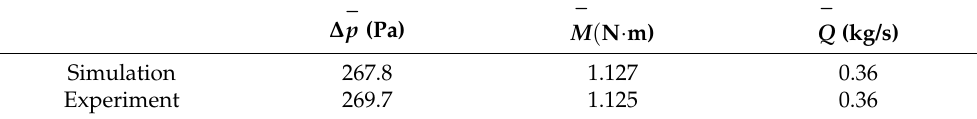
Table 3. Time-averaged performance of the fan.